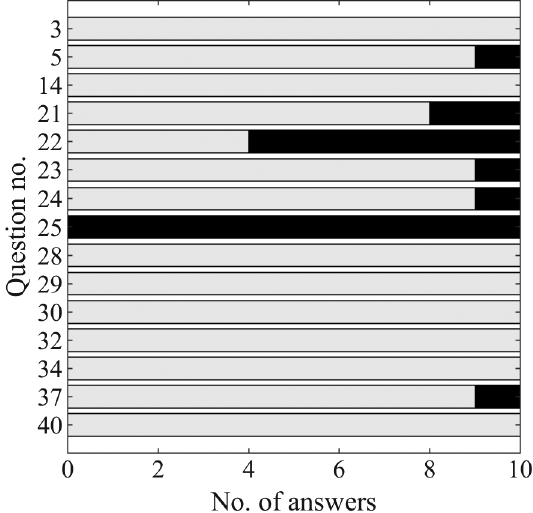
FIG. 3. The final coding of the 15 statements included in the analysis by the two raters. X axis: number of student answers, y axis: question number. Gray indicates answers coded to factors assigned by Douglas et al. [11], black indicates answers coded to other